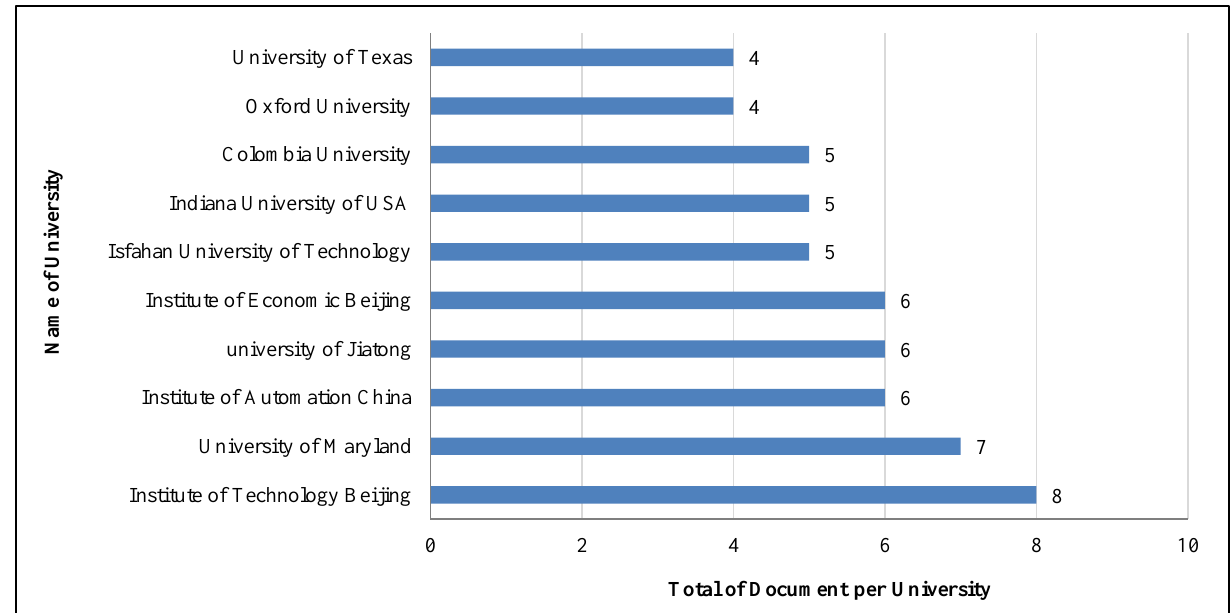
Figure 3. Institutional affiliations of authors producing most theory-related policy research